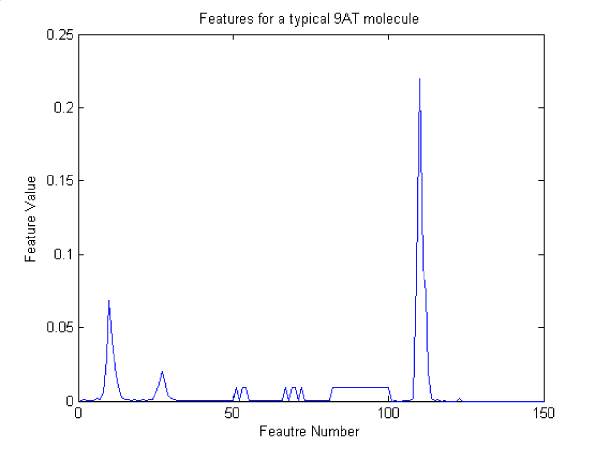
Features for a typical 9AT type molecule.